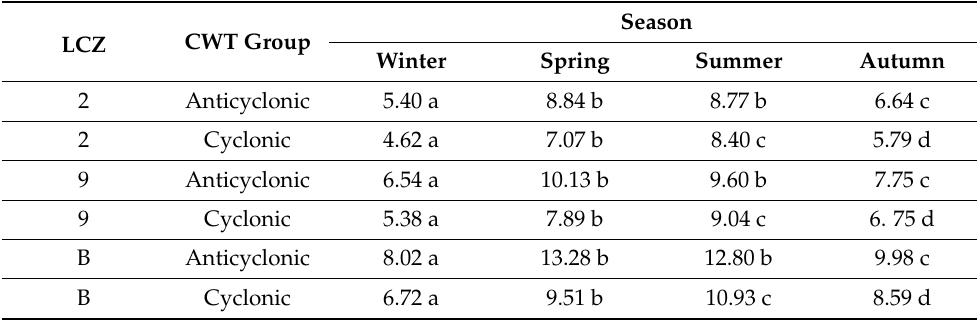
Table 4. Significance of the difference among seasons for each LCZ and CWT. Average values ( ◦ C) are shown. Letters a, b, c, d represent significant differences among groups.